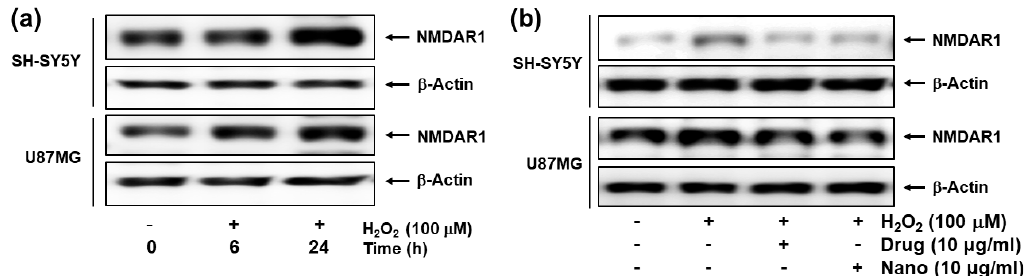
Figure 7. ( a ) The effect of H 2 O 2 on the NMDAR1 expression of cells. ( b ) The effect of memantine and bCDsuMema nanoparticles on the NMDAR1 expression of cells. Cells were pre-treated with memantine, or nanoparticles were treated for 1 h and then exposed to H 2 O 2 (final concentration: 100 µ M) for 6 h. Drug = memantine; Nano = bCDsuMema nanoparticles.